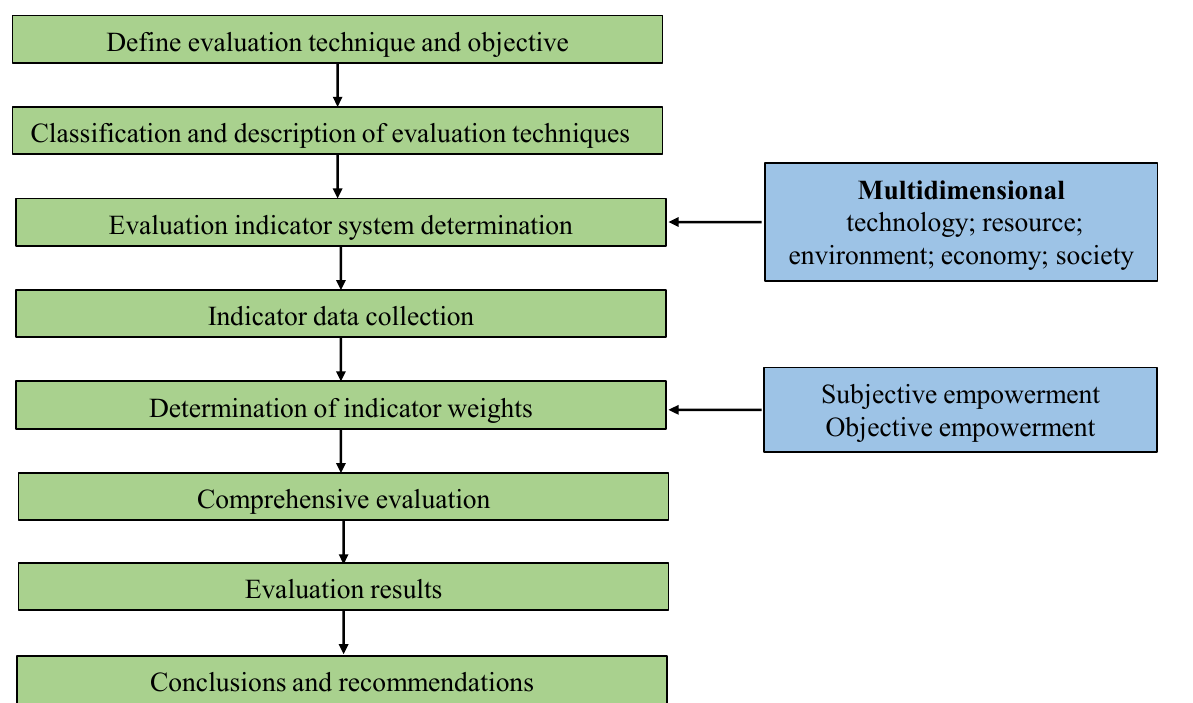
Figure 1. Comprehensive evaluation method framework.